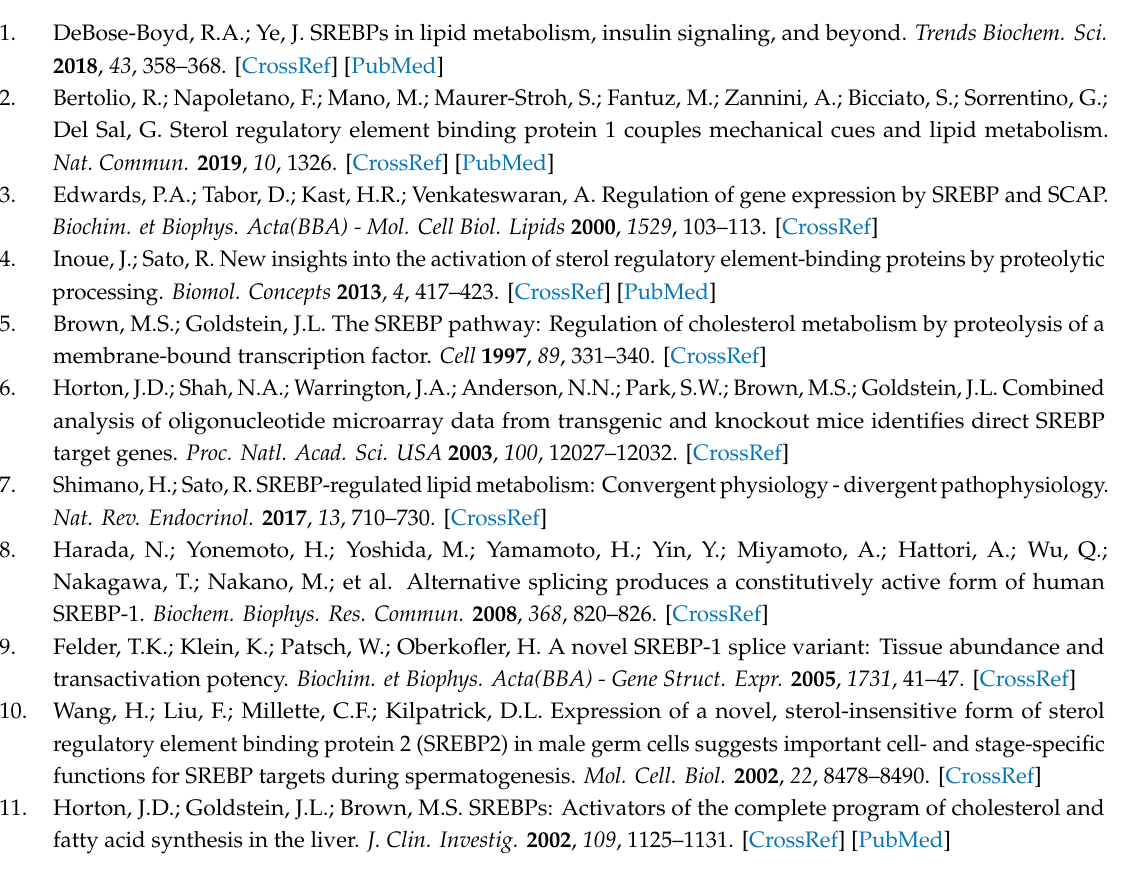
Table S1: Triglyceride levels in serum and liver of non-treated S. aurata and S. aurata treated with chitosan-TPP-pSG5 and